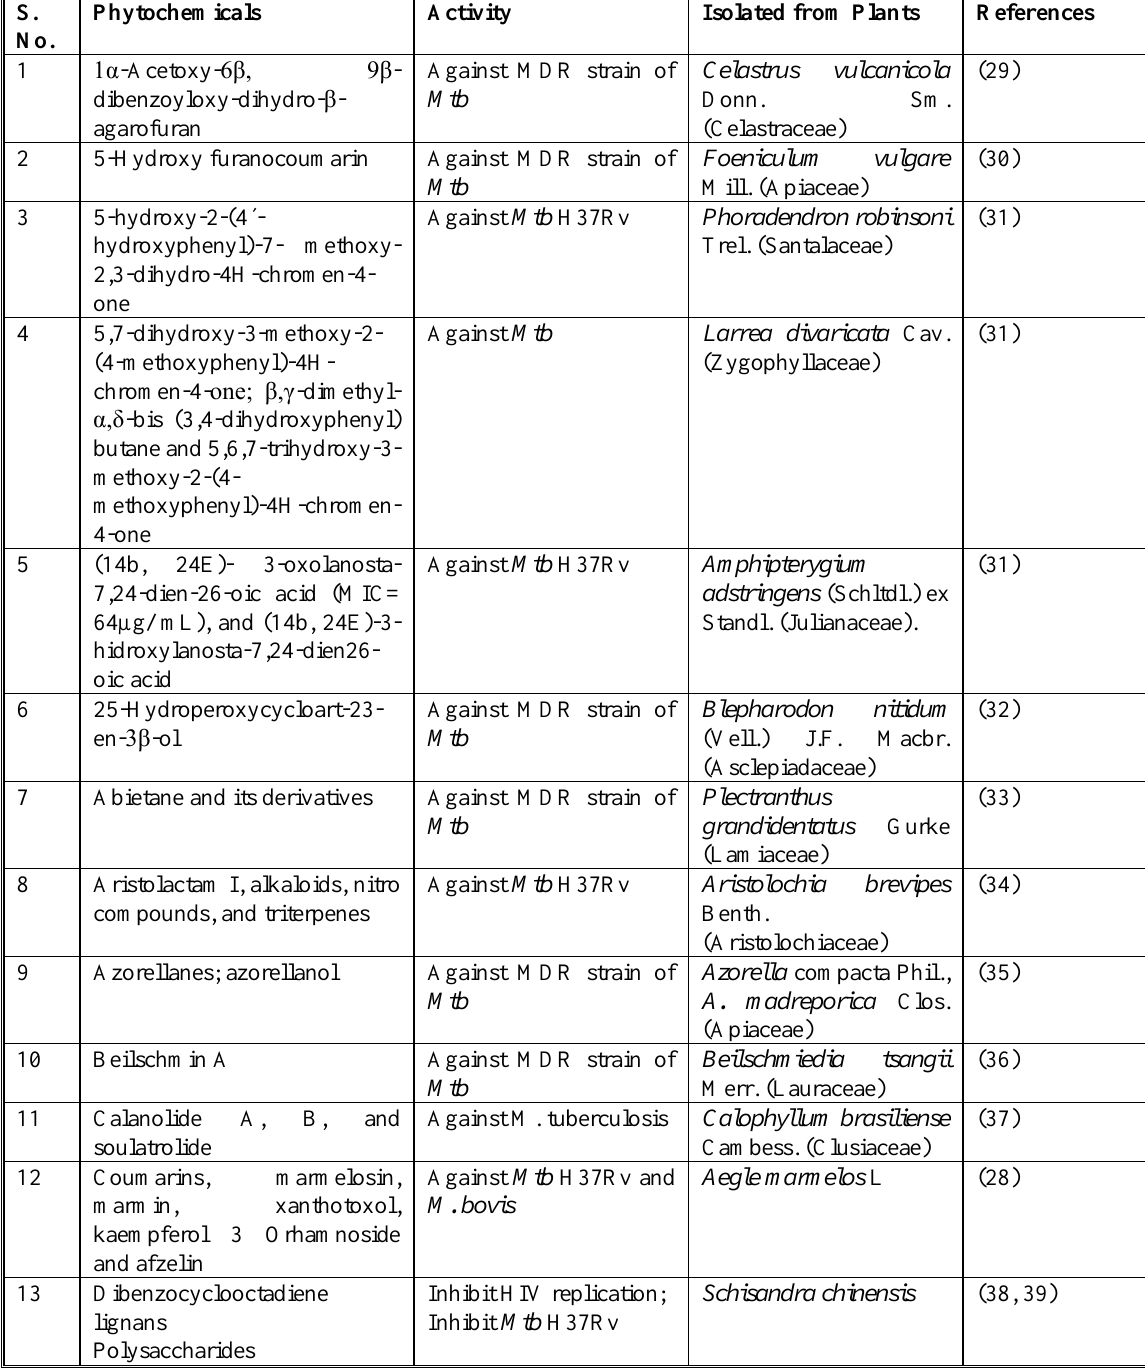
Table 2. Phytochemicals having potent anti-TB activity